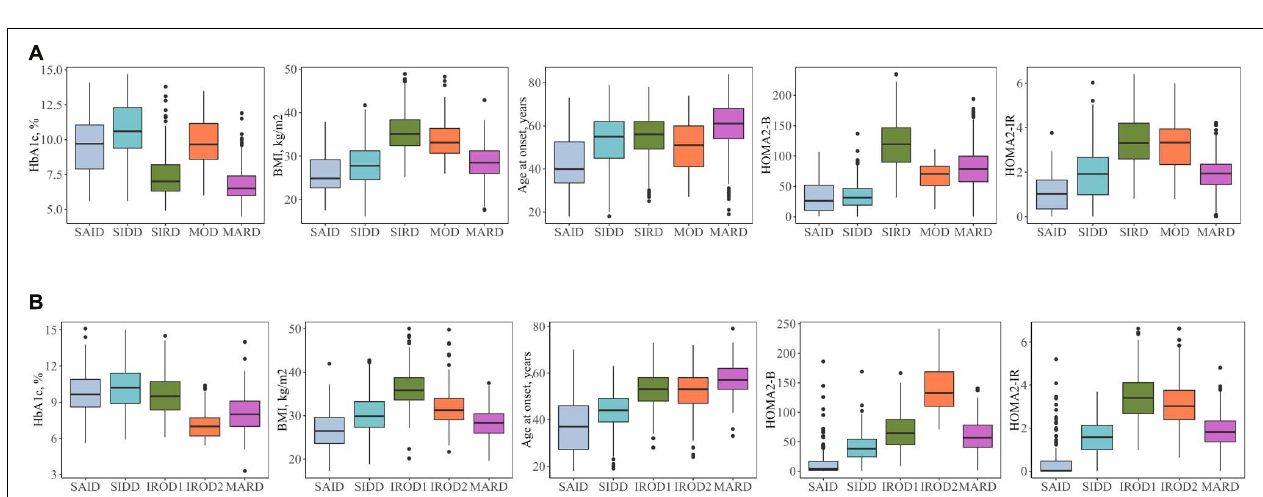
FIGURE 1 | Frequency distribution of clusters in the DOLCE study. (A) Individuals with new-onset adult diabetes with less than 3 years of disease duration ( n = 887). (B) Individuals with long-term adult diabetes with more than 3 years of disease duration ( n = 1,253).